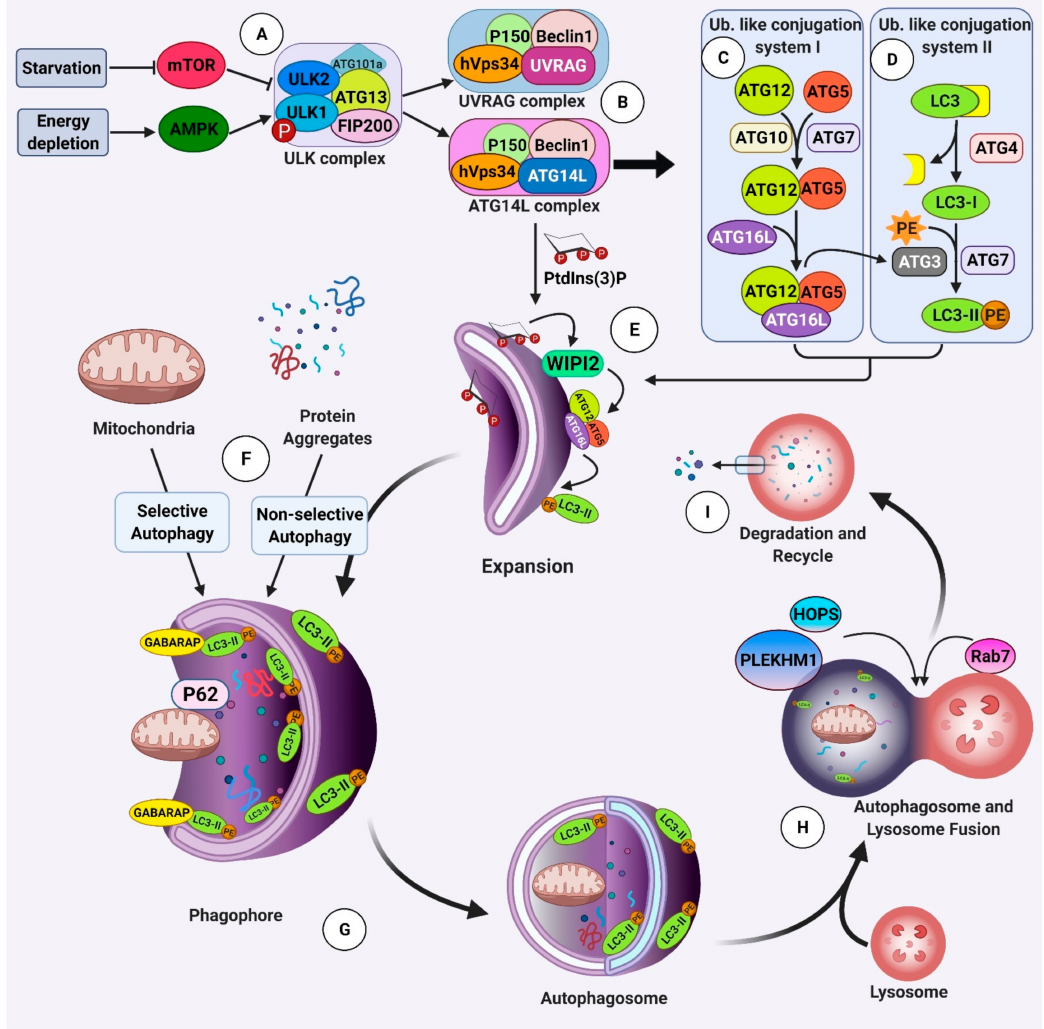
Figure 2. Brief molecular mechanisms of macro autophagy. Autophagy is highly regulated by cascades of multi-molecular complexes consisting of ATG proteins. ( A ) In mammalian cells under physiological conditions, the master switch, mTOR, hinders autophagy by inhibiting the autophagy initiation complex, ULK complex, which consist of ULK1/2, ATG13, FIP200, and ATG 101a. During starvation, because of mTOR inhibition, the ULK complex is activated, triggering autophagy initiation. Additionally, energy depletion activates AMPK, leading to ULK1 phosphorylation, which promotes the assembly of the ULK complex. ( B ) ULK complex activates PtdIn3K complexes including UVRAG and ATG14L complexes. UVRAG complex is involved in autophagosome and lysosome fusion. ATG14L, consisting of Beclin1, hVps34, P150, and ATG14L, triggers the PtdIns(3)P generation required for nucleation and expansion of the phagophore. The autophagy process is followed by the activation of two ubiquitin-like conjugation systems, ATG5-ATG12 conjugation, and LC3 lipidation. ( C ) In the first conjugation system, integration of ATG5 and ATG12 is accrued with the help of ATG7 and ATG10. Then, ATG16L is added to the complex, forming ATG5-ATG12-ATG16L conjugate. ( D ) In the second system, LC3 is cleaved at the C terminus by Atg4, generating LC3-I. Then, LC3-I is conjugated to phosphatidylethanolamine (PE) by a function of ATG7 and ATG3. ( E ) ATG5-ATG12-ATG16L complex localize on the phagophore surface by the help of PtdIns(3)P binding proteins, such as WIPI2. This triggers ATG3 activation and LC3 lipidation. ( F ) The autophagy targets, such as protein aggregates and cytoplasmic components, can be non-selectively sequestrated within the double membrane contract, autophagosome. Selective autophagy targets specific cellular components for degradation using different adaptor proteins, such as P62. ( G ) Autophagosome is formed upon completion and closure of the phagophore membrane by the help of LC3 and GABARAP proteins. ( H ) Autophagosome, the completed phagophore, is then fused with lysosome with the help of other proteins such as Rab7 on the lysosome and HOPS and PLEKHM1 on the autophagosome surface. ( I ) Subsequently, targets of autophagy are degraded by lysosomal hydrolases, and their building blocks are recycled back into the